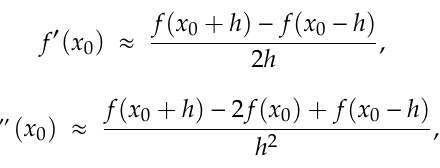
Figure 7. Feature points detected over the RGB image. The estimations of the weld bead dimensions are performed using a laser triangulation algorithm. Calculating the distance between the weld bead edges feature points (left and right features points of Figure 7) allows estimation of the weld bead width, W , in pixels. Calculating the distance between the weld bead center feature point and the line joining the weld bead edges feature points allows estimation of the weld bead height, H , in pixels. These values are converted to millimeters by applying a scale factor depending on the distance between the camera and the examined area. For post-welding inspection, 60 images per vessel are also analyzed, one at a time. For each of them, the weld bead height and width are computed. If, for all the images, these values are in the corresponding intervals (i.e., 0.5 mm ≤ H ≤ 1.5 mm and 7.0 mm ≤ W ≤ 9.0 mm), the vessel is labeled as acceptable, and is submitted to further operations. On the contrary, if, for a given image, any of these values are below the lower limit (i.e., H < 0.5 mm or W < 7.0 mm), the inspection process is interrupted, the vessel is classified as defective, and is removed from the production line. Finally, if, for a given image, any of the dimensions are above the upper limit of the corresponding intervals (i.e., H > 1.5 mm or W > 9.0 mm), the vessel is still labeled as acceptable, but a warning is emitted to the operator for considering a possible readjustment of the welding parameters, for preventing material and energy wasting. All the information generated by the system is stored in the server. 3. Results A dataset containing 1090 images, divided into 872 images for training and 218 for validation, was used for the parametrization of the CNN. Of the total images, 565 had a misalignment value inferior to 1 mm and were labeled as “correct alignment”; and 525 images had a misalignment value